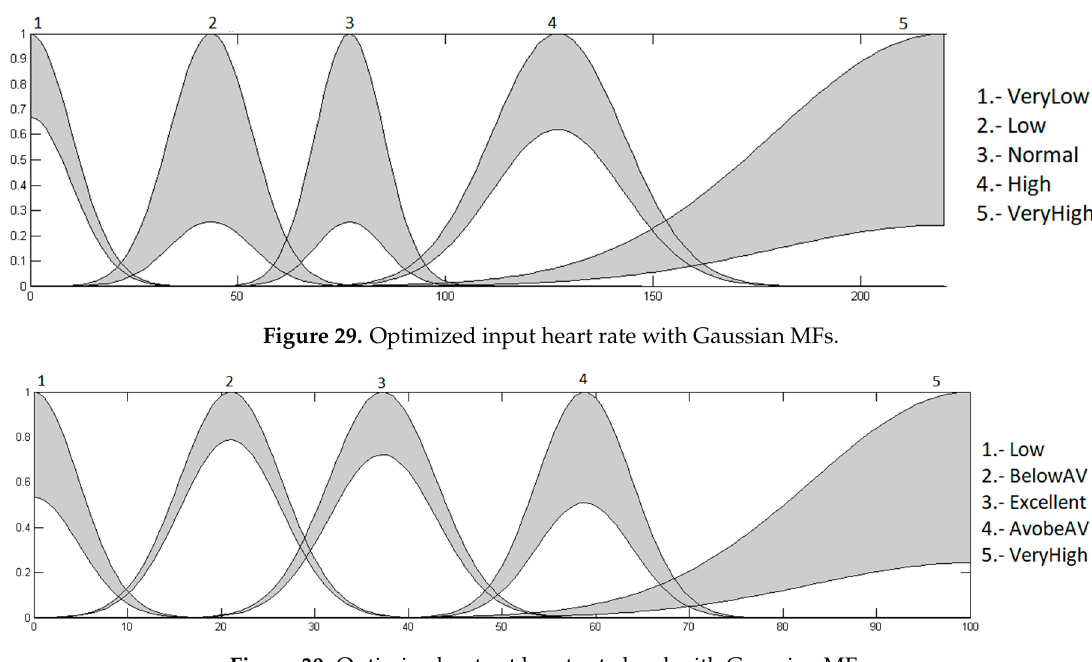
Figure 30. Optimized output heart rate level with Gaussian MFs.